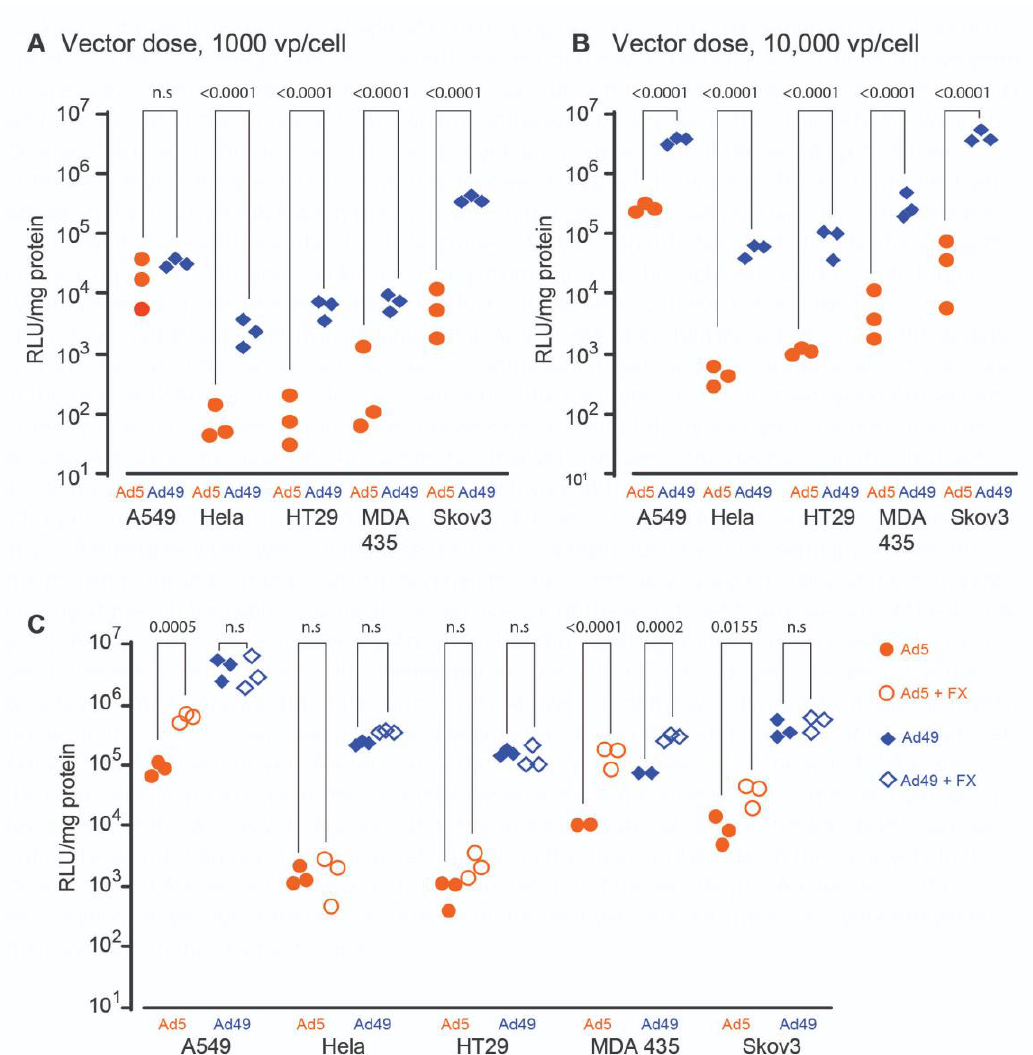
Figure 1. Profiling of HAdV-D49 transduction in cancer cell lines in vitro. Transduction of HAdV-C5 (shown as Ad5) and HAdV-D49 (shown as Ad49) in A549, HeLa, HT20, MDA 435, and SKOV3 cell lines at ( A ) 1000 vp/cell and ( B ) 10,000 vp/cell. Luciferase expression was measured 48 h post-infection. ( C ) Transduction of the same cell lines using 5000 vp/cell, in either the presence or absence of recombinant FX. n.s: not statistically significant, p > 0.05.